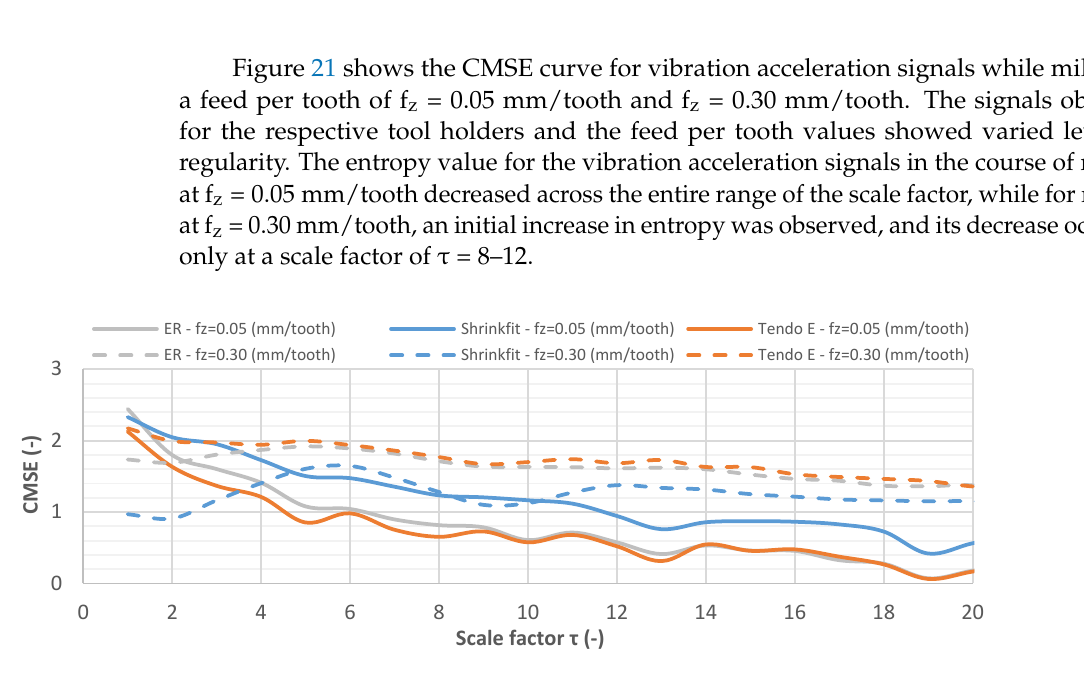
Figure 20. CMSE for vibration acceleration signals while milling at v c = 400 m/min and v c = 1000 m/min (f z = 0.15 mm/tooth, a p = 6 mm).